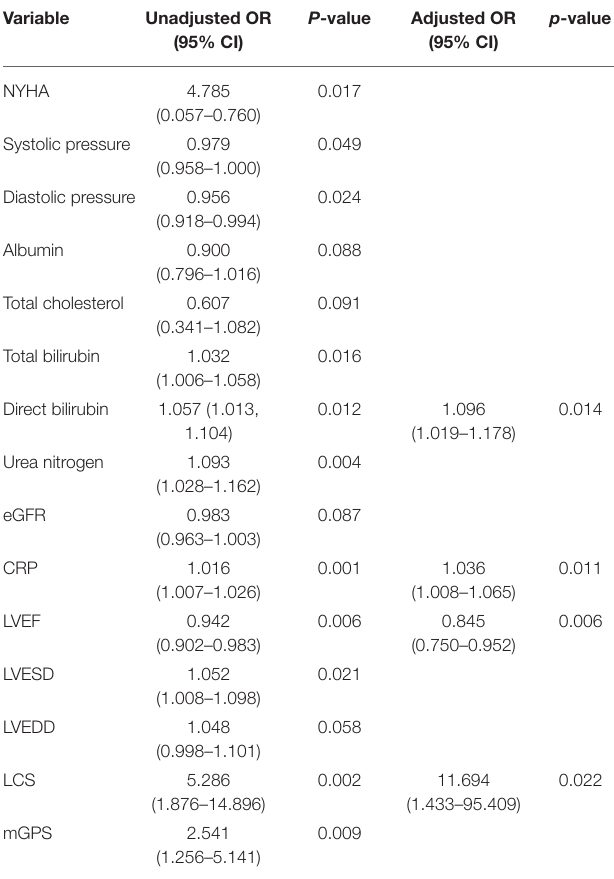
TABLE 3 | Univariate and multivariate analysis of variables associated with prognosis in patients with acute heart failure.